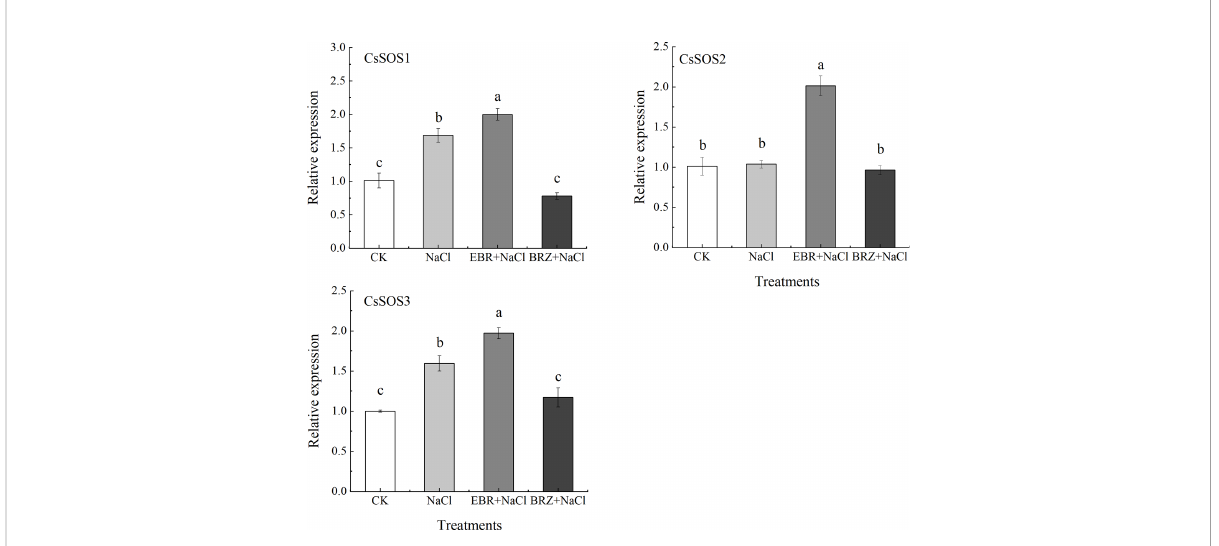
FIGURE 9 Effect of exogenous EBR on the expression of CsSOS1 , CsSOS2 , and CsSOS3 genes in cucumber seedlings under salt stress. With CsActin as the internal parameter, the relative expression was calculated by 2 - DD Ct method, and value represents mean ± SE of the three biological replications. Different letters indicate signi fi cant differences at P < 0.05 according to Duncan ’ s multiple range